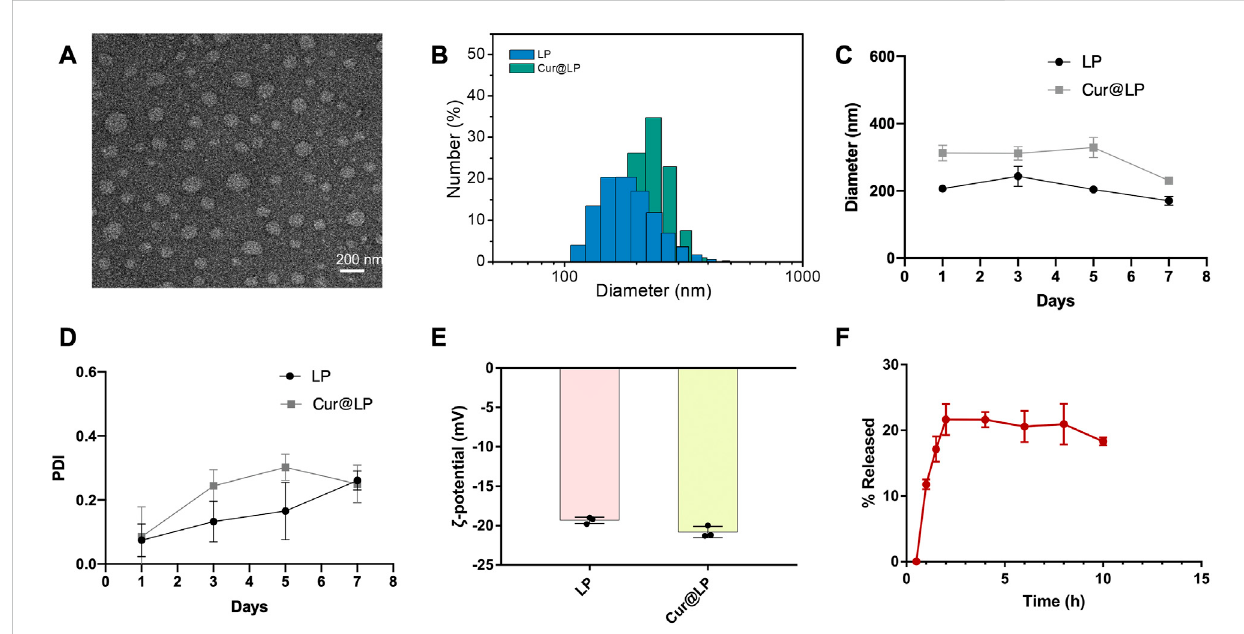
FIGURE 2 (A) RepresentativeTEMmicrographoftheCur@LP. (B,C) ParticlesizesoftheLPandCur@LP. (D) PDIoftheLPandCur@LP. (E) Zeta-potentialsofthe LP and Cur@LP. (F) In vitro release behavior of the Cur@LP at 37 °